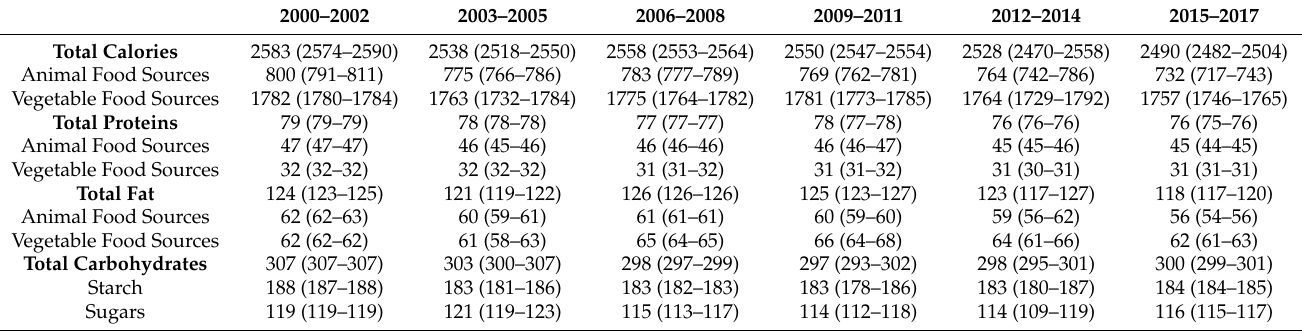
Table 2. Average per capita supply of Energy (Kcal/per capita/day) and Macronutrient Supply (g/per capita/day) by